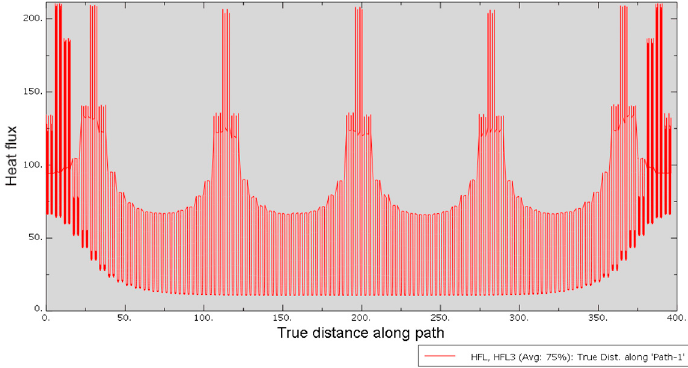
Figure 7. Heat flux (W · m − 2 ) of each node of concrete.